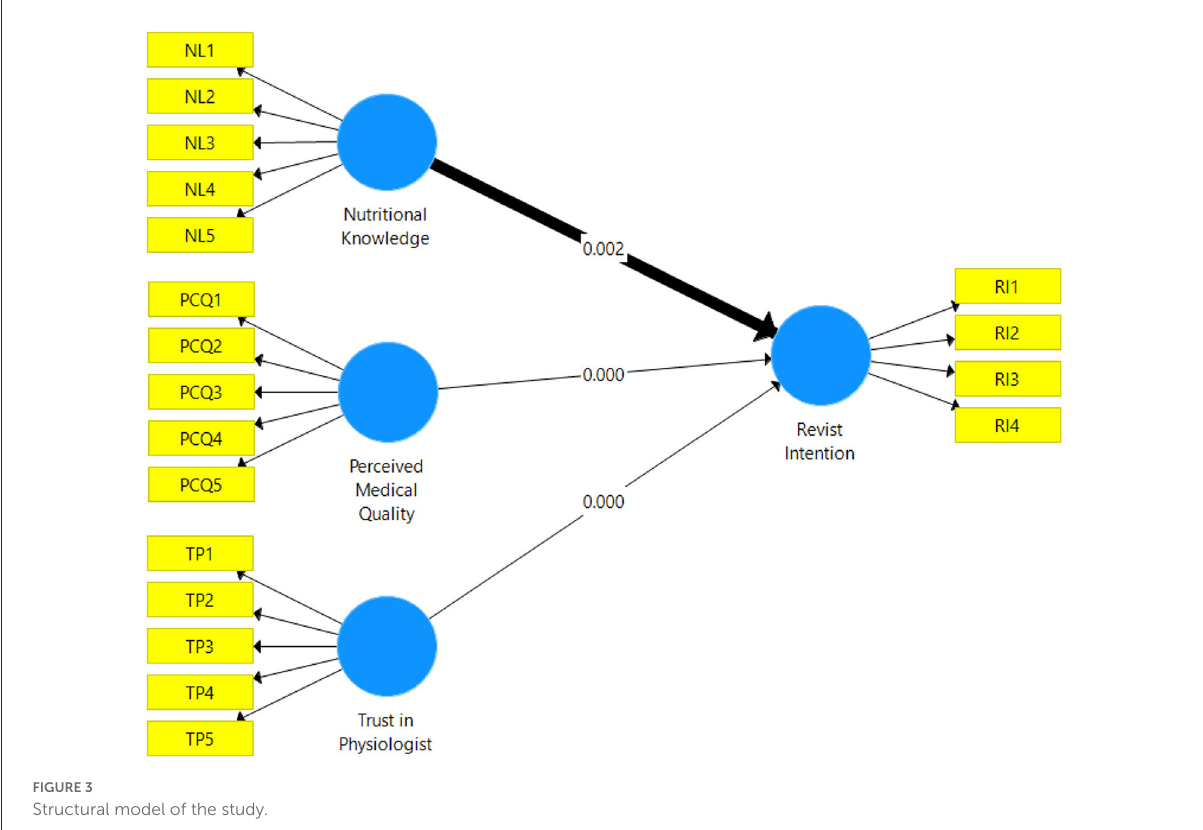
FIGURE3 Structural model of the study.